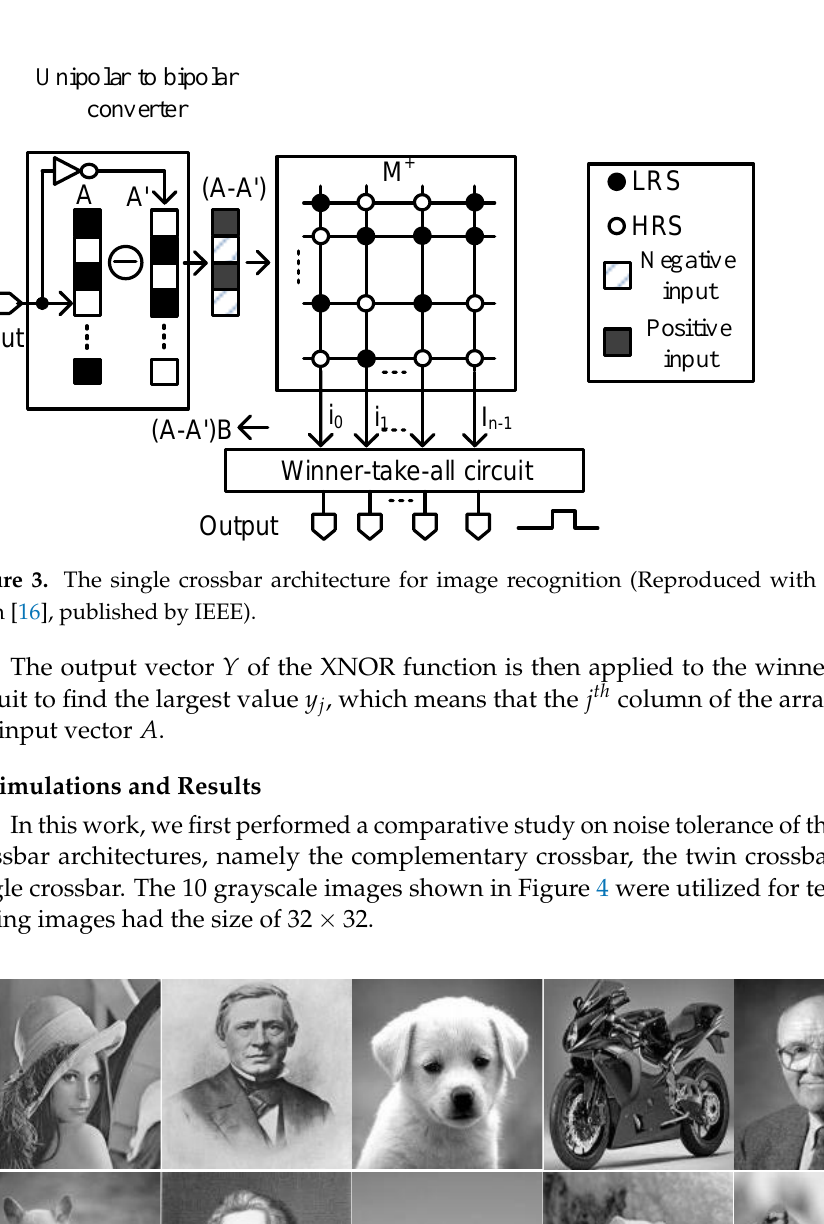
Figure 3. The single crossbar architecture for image recognition (Reproduced with permission from [16], published by IEEE).